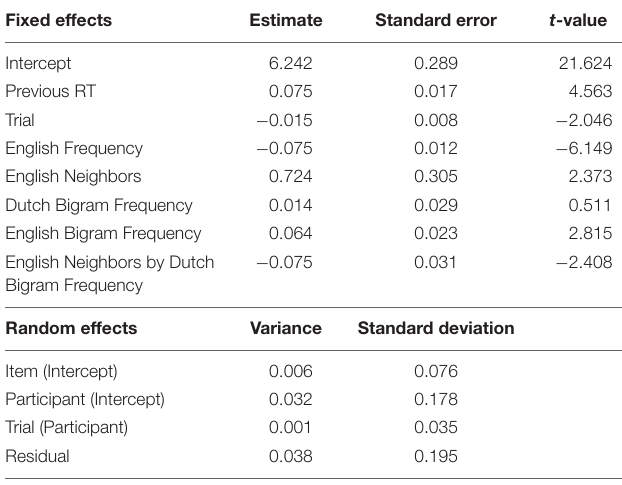
TABLE 9 | Final model for Experiment 3 (English Progressive Demasking with